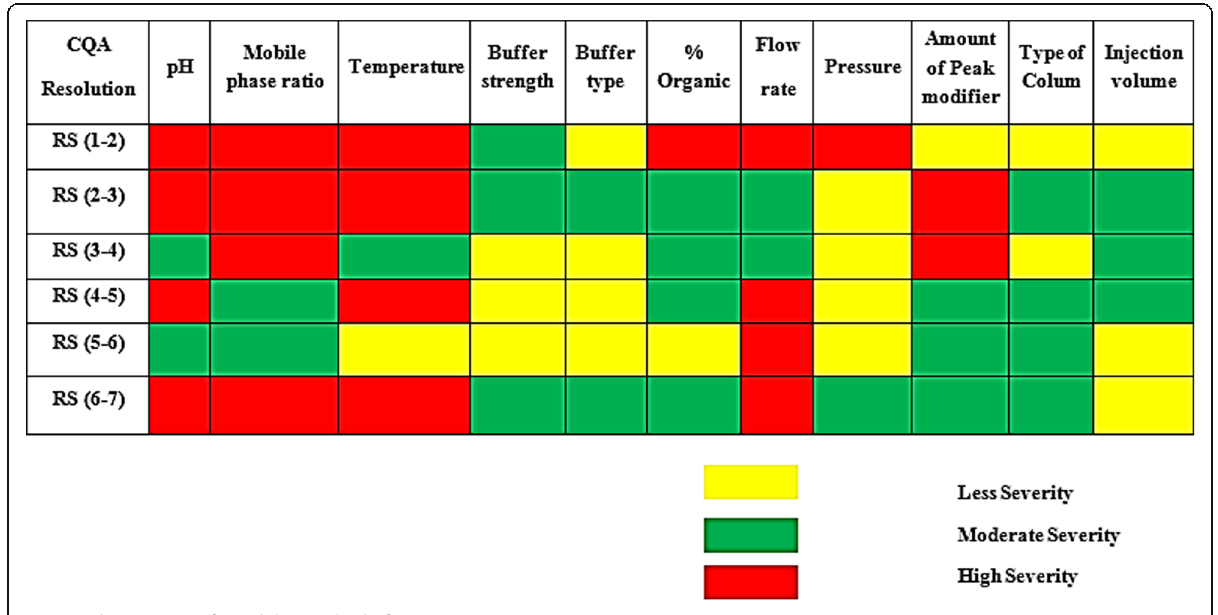
Fig. 3 Risk assessment for stability method of AV